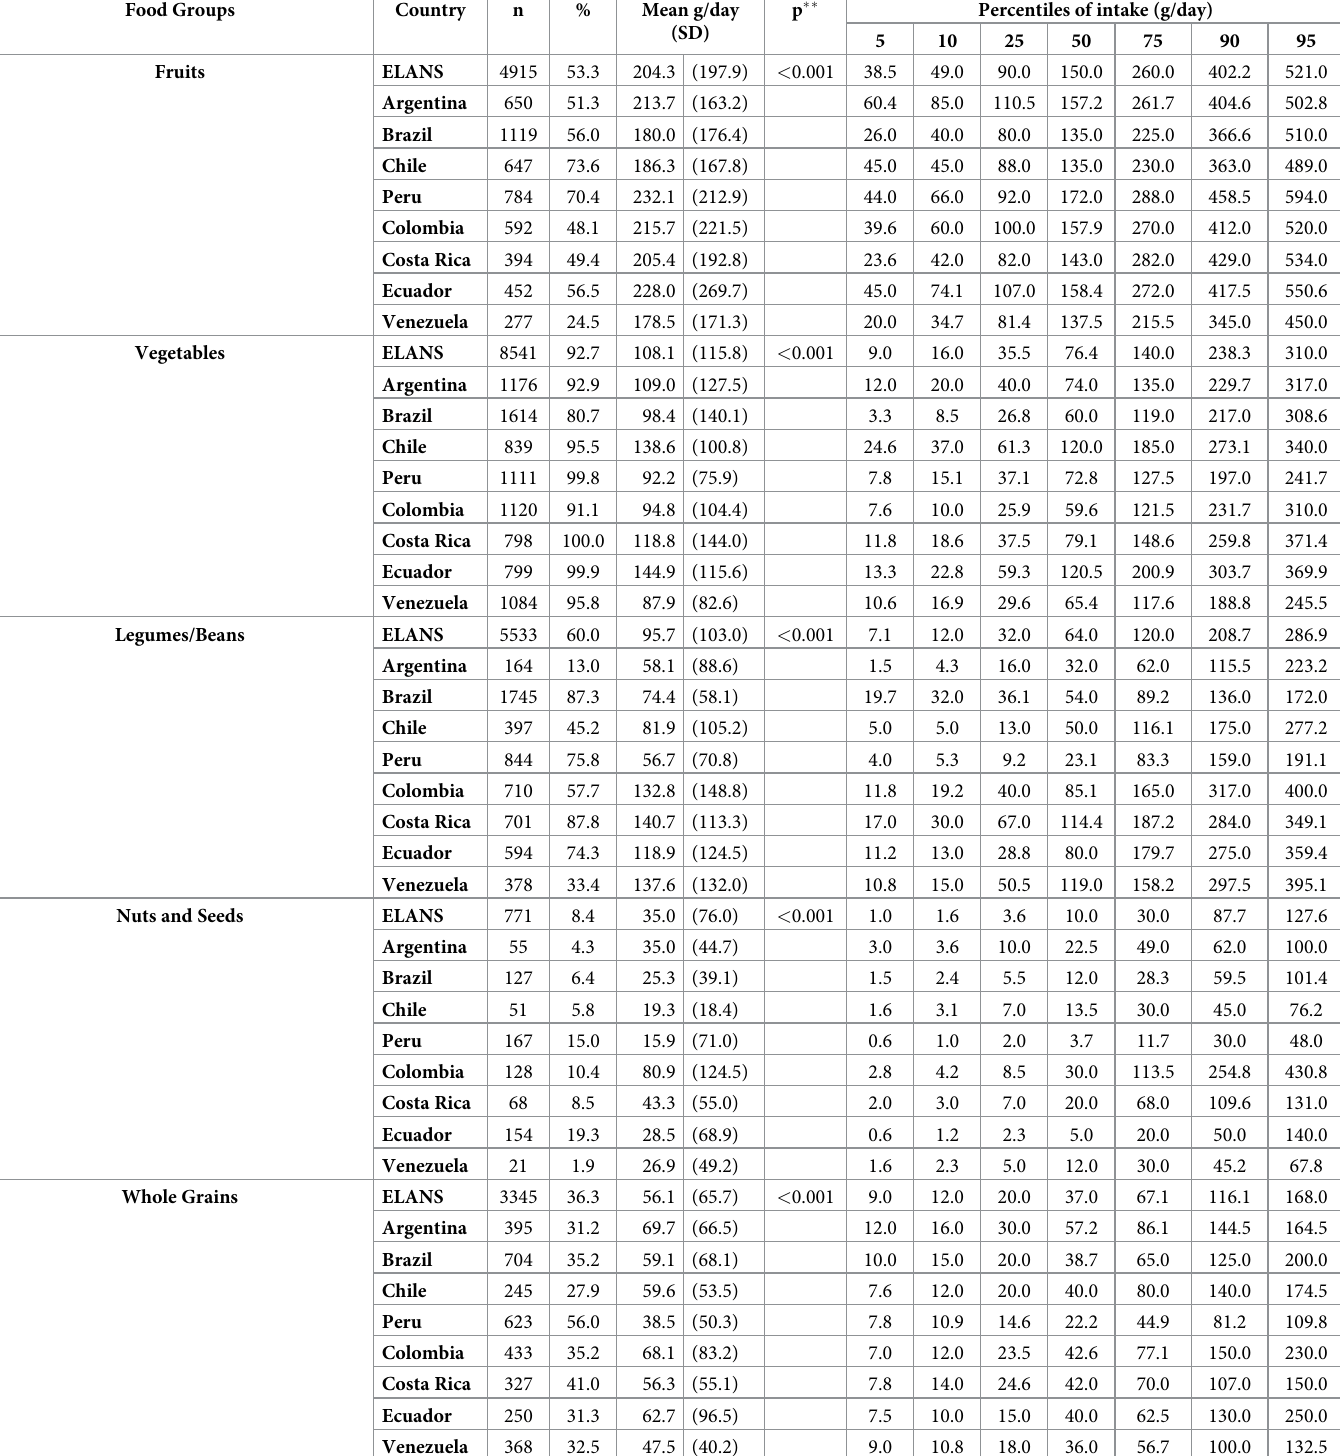
Table 5. Comparison of dietary intake of the ten major foods groups (grams/day) in individuals residing in urban areas of Latin America, according to the country of living. Data corresponds to consumers � only. Food Groups Fruits